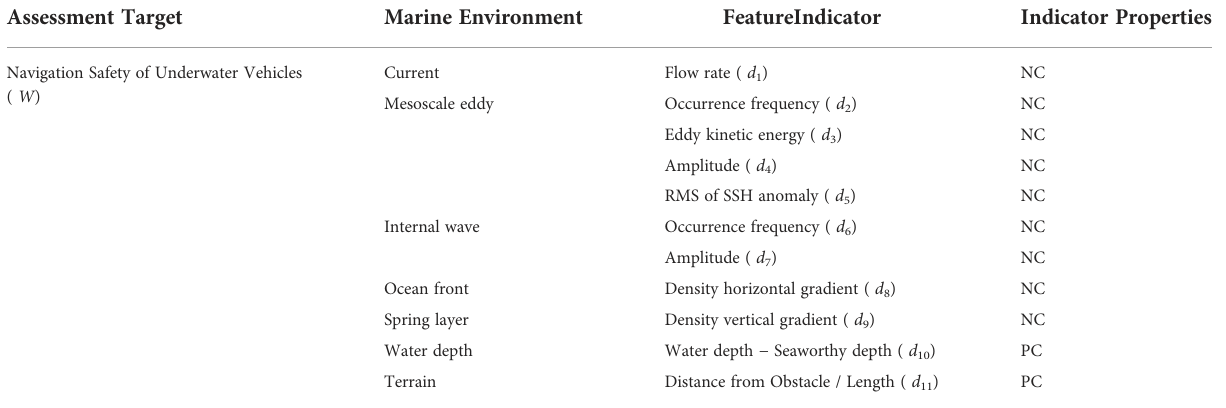
TABLE 1 Navigation safety assessment index system.